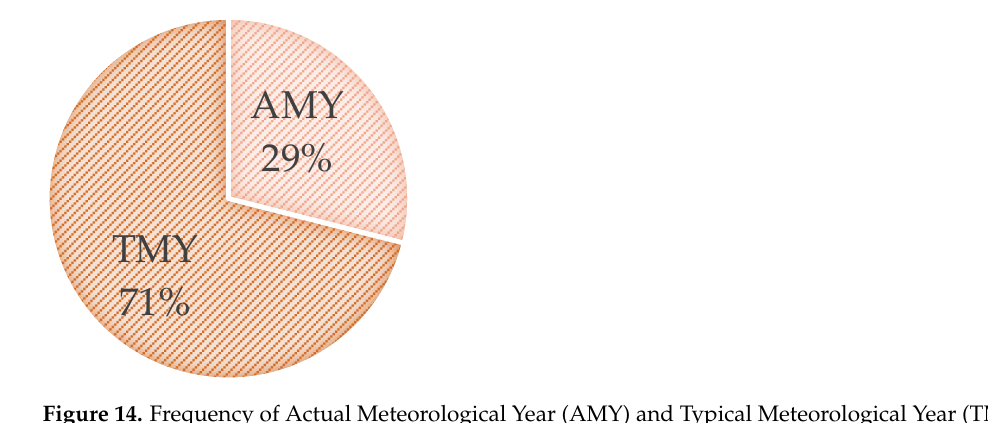
Figure 14. Frequency of Actual Meteorological Year (AMY) and Typical Meteorological Year (TMY) in urban building energy modeling and simulation.